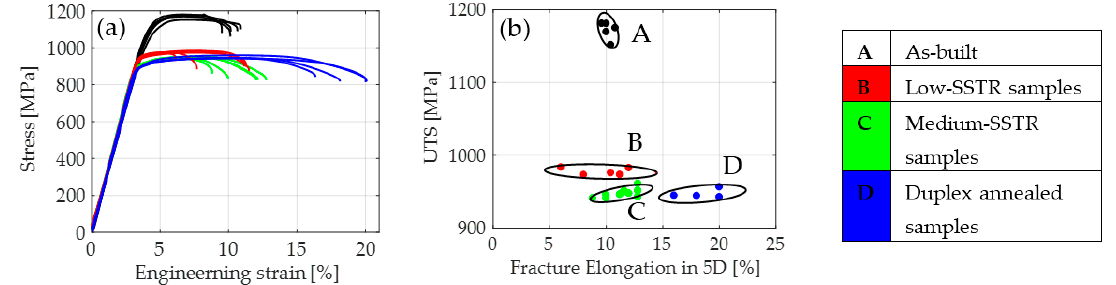
Figure 5. Plot of ( a ) tensile stress-strain curves and ( b ) ultimate tensile strength (UTS) vs fracture elongation for the four groups of tensile samples.